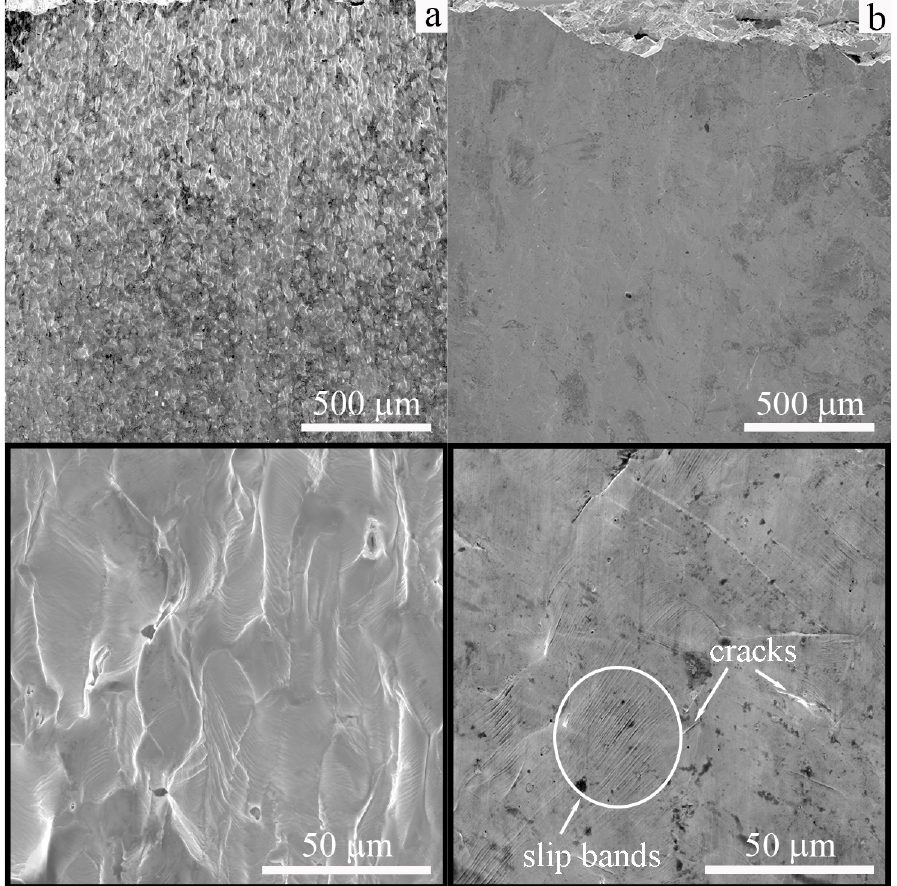
Figure 7. SEM images of the lateral surfaces of the low-carbon steel: ( a ) cast and ( b ) EBAM. Specimens were tensile tested to failure at 77 K.